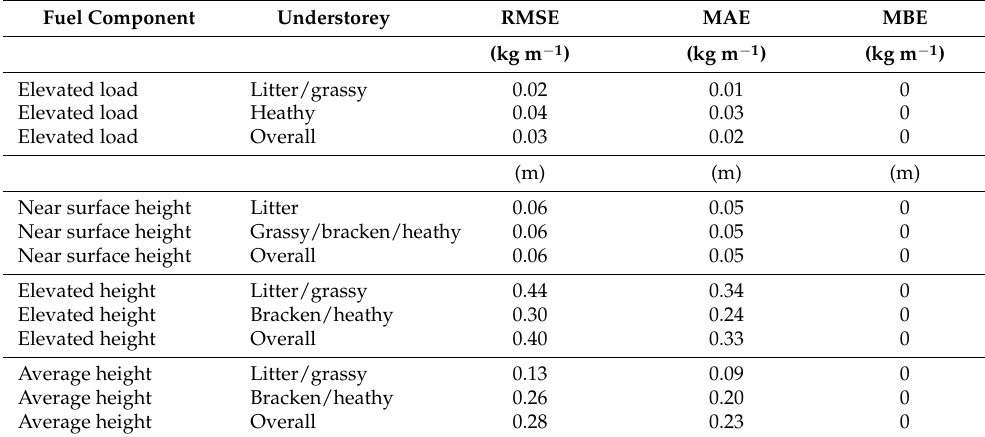
Figure 5. Step model for elevated fuel load for SE sites. Litter/grassy—empty circles, model—dashed line, heathy—black circles and dashed/dotted line, combined model—solid line. Table 7. Goodness-of-fit statistics for step models. MBEs for all models are zero because of the type of fitted